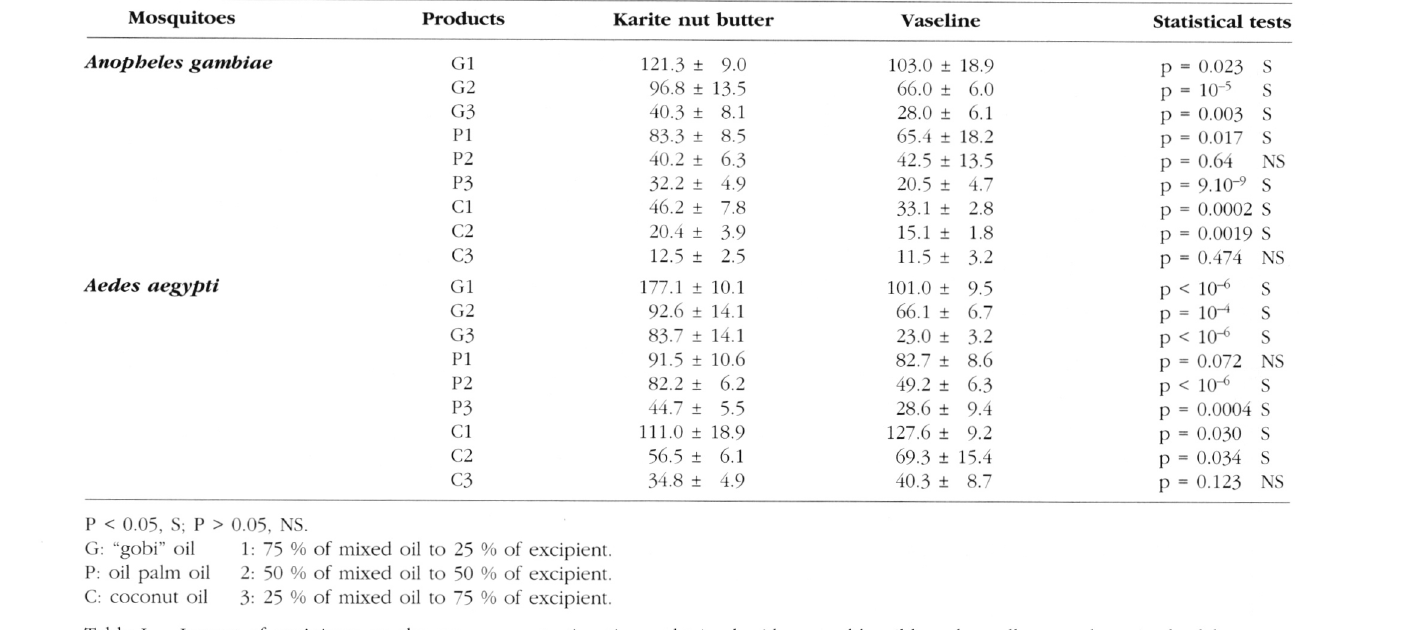
Table I. - Impact of excipients on the average protection times obtained with vegetable oil-based repellent products in the laboratory.